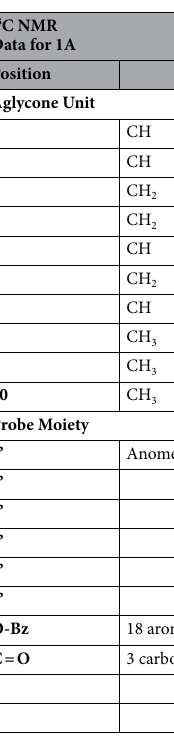
Table 1. Chemical carbon shifts for molecule